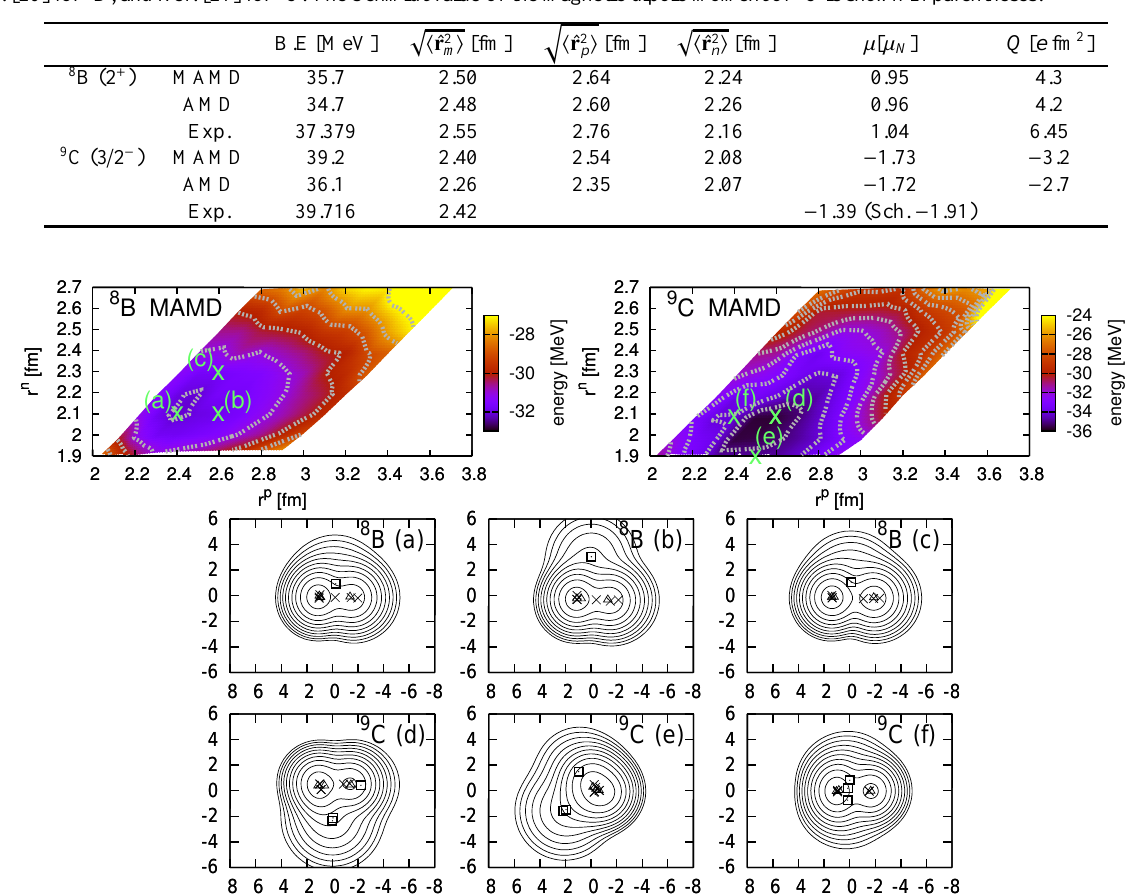
Fig. 3. Energy surface and the density distribution of 8 B and 9 C. Energy surface is calculated with the angular momentum projected wave functions (2 + for 8 B and 3 / 2 − for 9 C), and contour lines are plotted with intervals of 1 MeV. Centers of Gaussian wave packets are plotted by symbols in the density distribution. Triangles represent the neutron wave packets, whereas crosses and squares represent the proton wave packets that are narrow and wide,